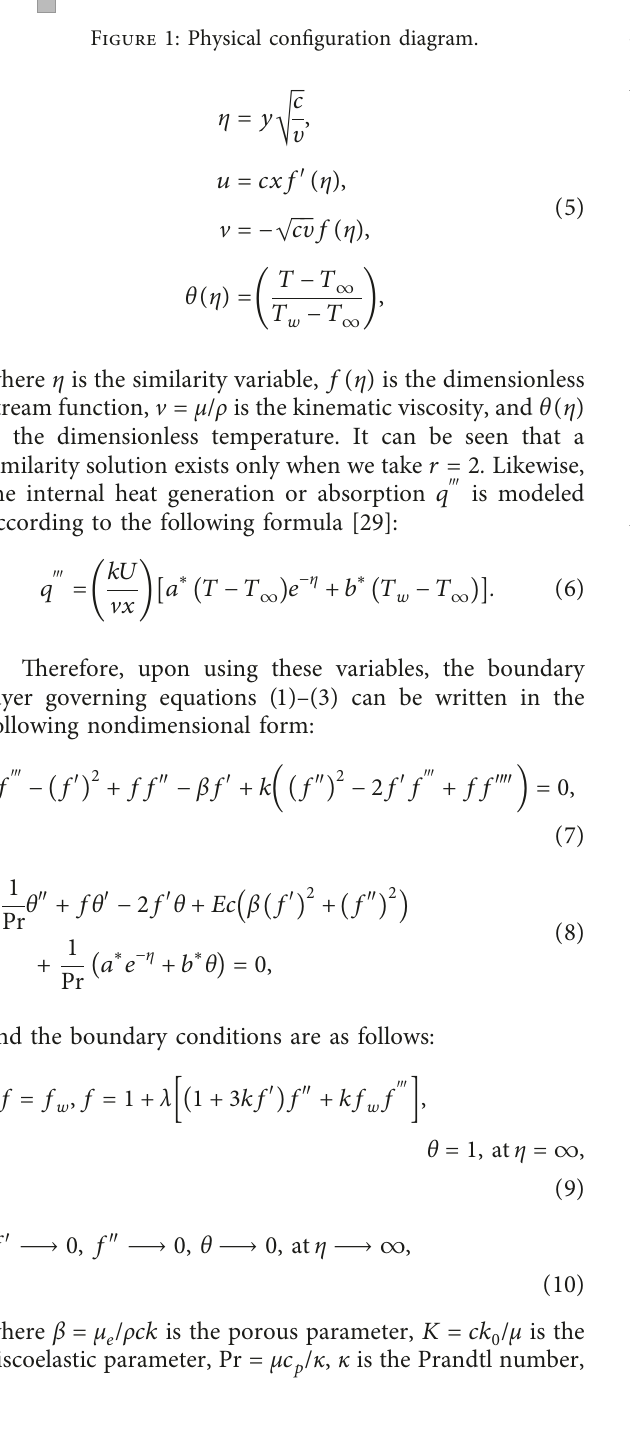
Figure 1: Physical configuration